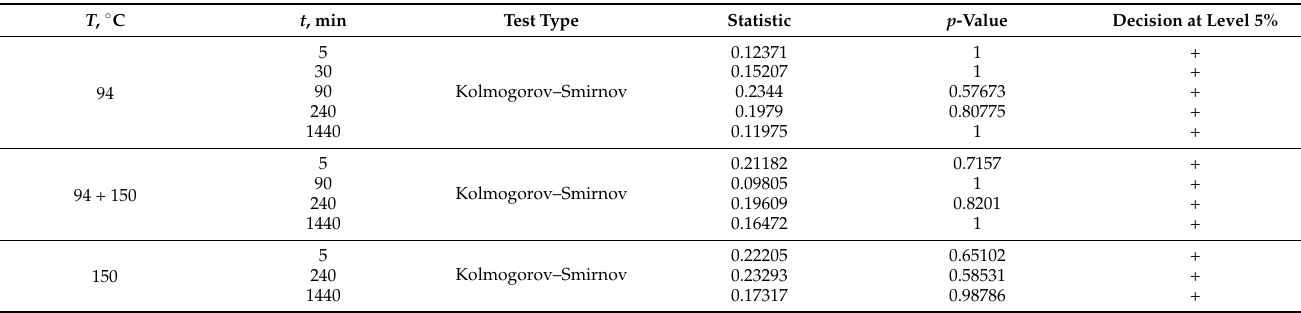
Table 3. Statistical parameters of the lap shear strength distribution for PET–PET interfaces estimated in several normality tests. Test Type Statistic p